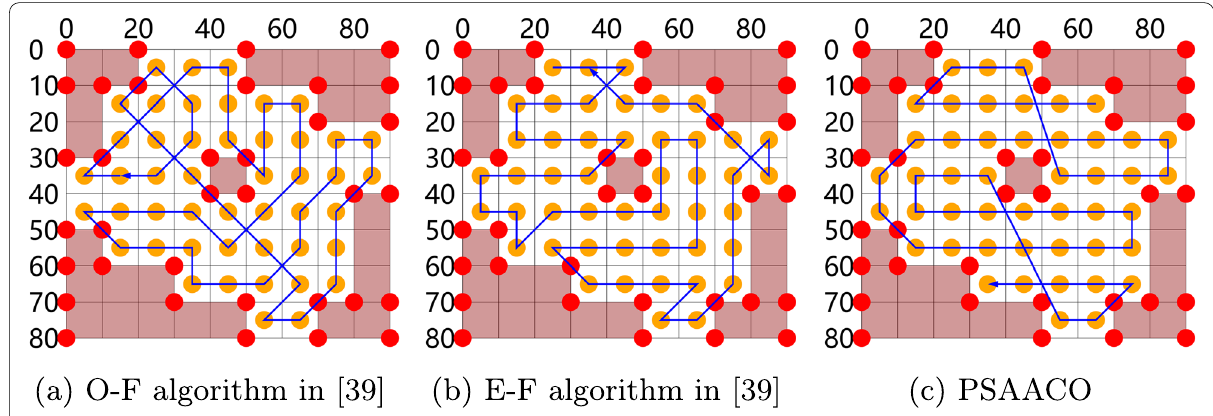
Fig. 14 Paths planned on area 3 by the algorithms in [39] and PSAACO